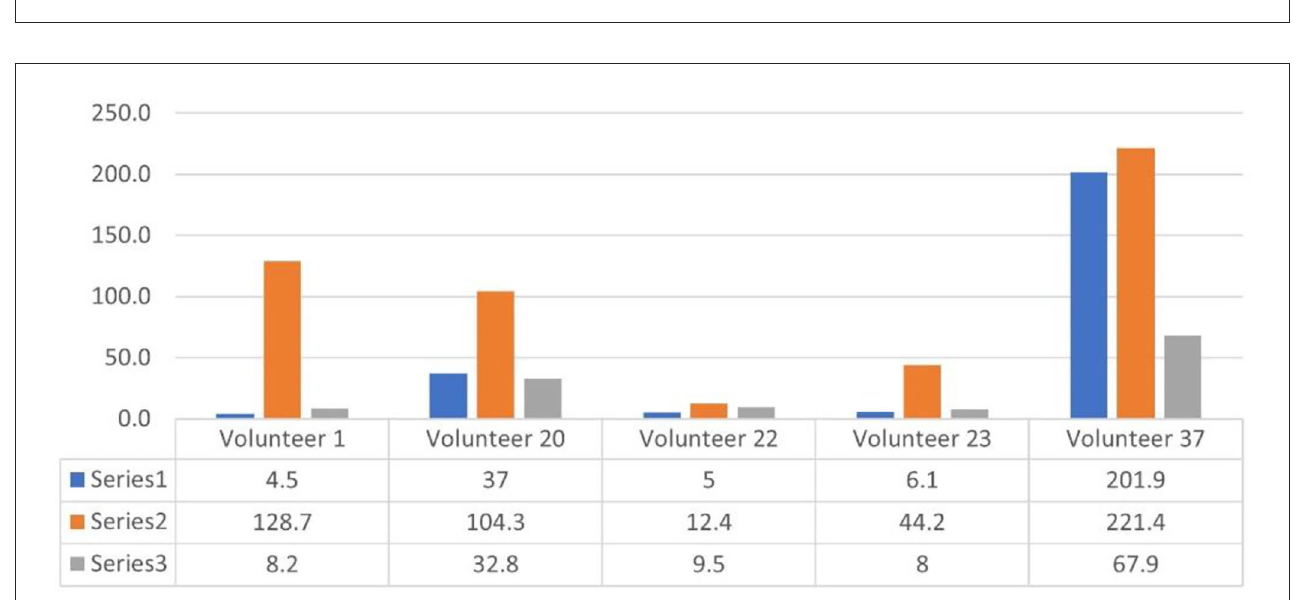
FIGURE8 Mean absolute error (measured in pixels) of the five volunteers over the three stages.